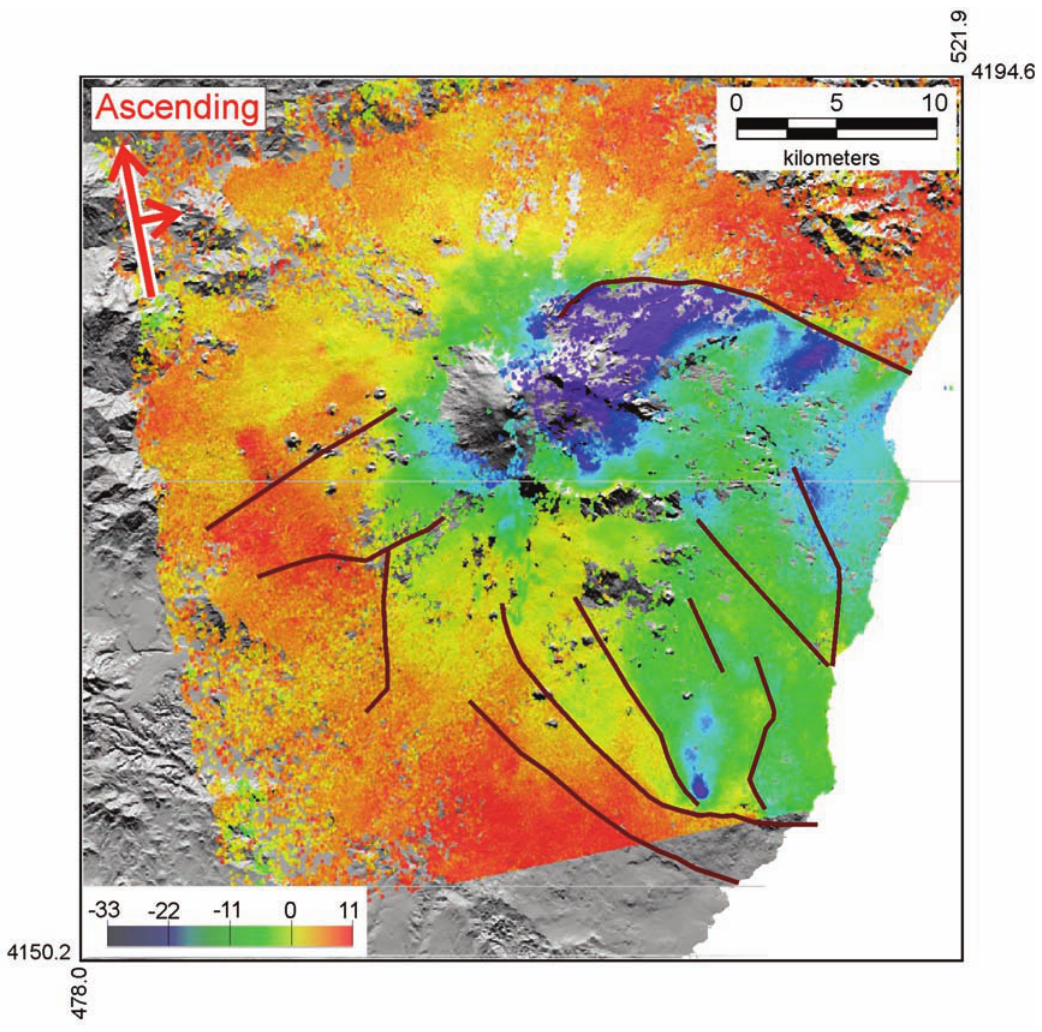
Figure 8. Mean ascending line-of-sight ground velocity (mm/yr) referring to the 2007 to 2009 time span. The map was obtained using the persistent scatterer software, known as StaMPS/MTI [Hooper 2008], using all of the available ENVISAT ascending data that was acquired for Mt. Etna from January 2007 to October 2009. The main discontinuities in the permanent scatterers velocity field detected by Bonforte et al. [2011] are shown as brown line. Red arrows indicate the trajectory (from South to North) of the satellite and its look direction toward East. The colour scale is in mm/year. The bottom left and top right corner coordinates are in km (WGS84 Datum, UTM projection, zone 33